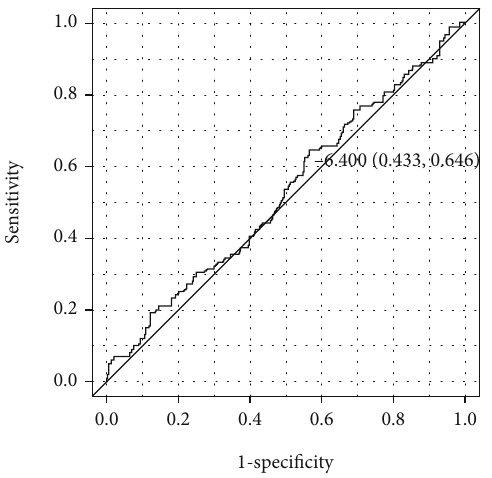
Figure 1: The receiver operating characteristic curve of the change in the eGFR and the concomitant use of